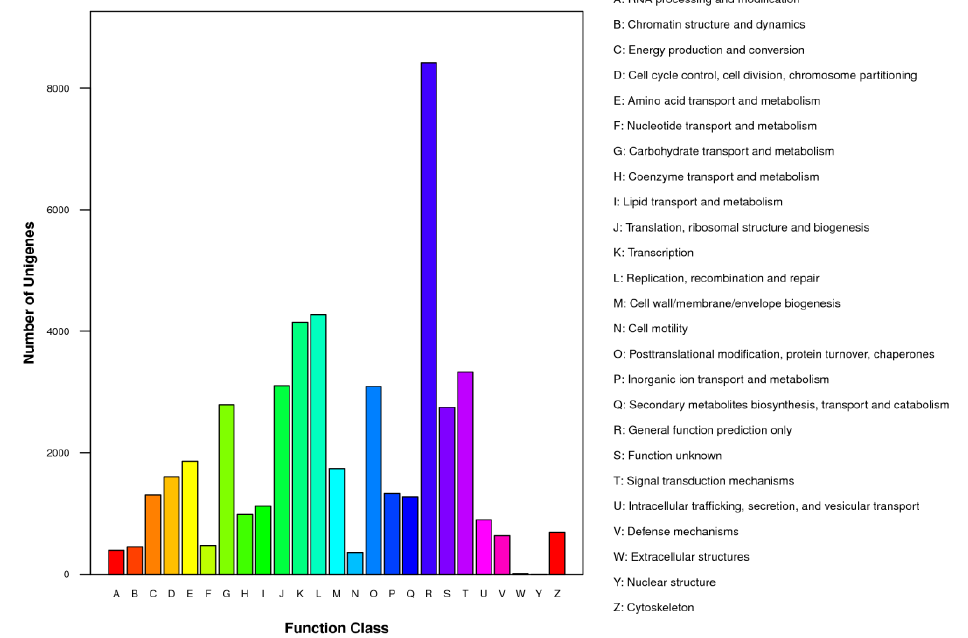
Figure 5. Results for the clusters of orthologous groups classification.